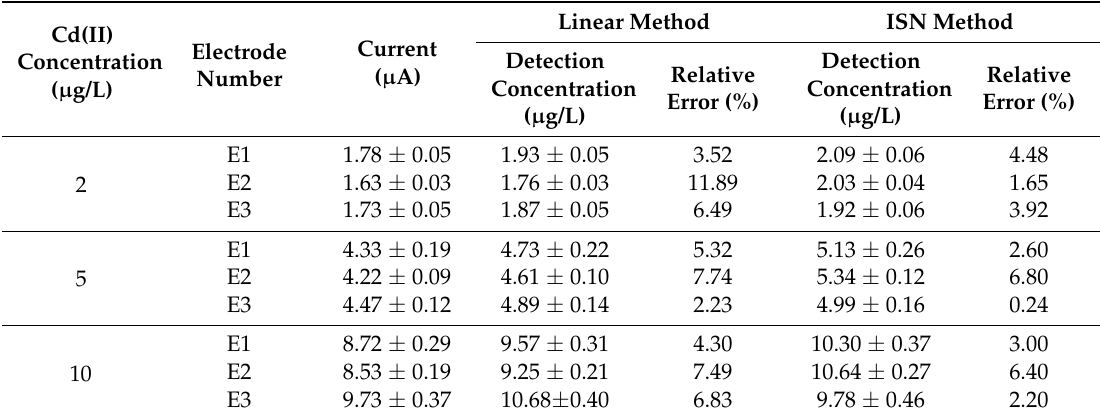
Table 1. Determination results of different Cd(II) concentration.